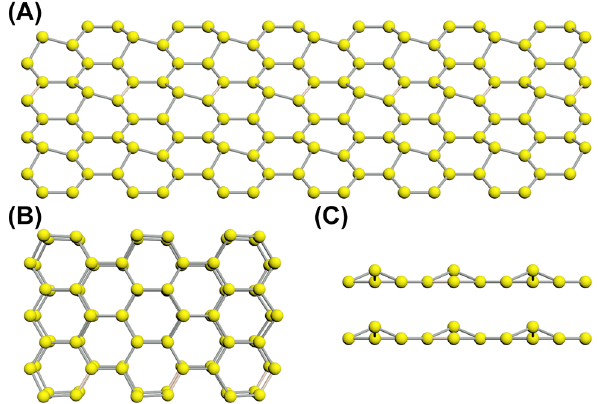
Figure 1: Structure of the germanium